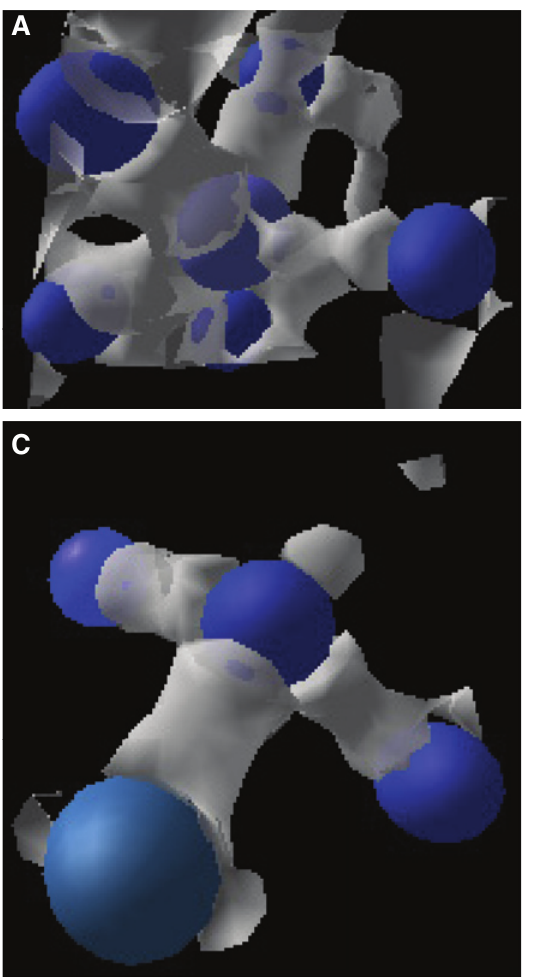
Figure 1: (A) Hybridization for a fivefold-coordinated atom, (B) the structural geometry of the fivefold-coordinated atom for (A), and (C) hybridization for a threefold-coordinated